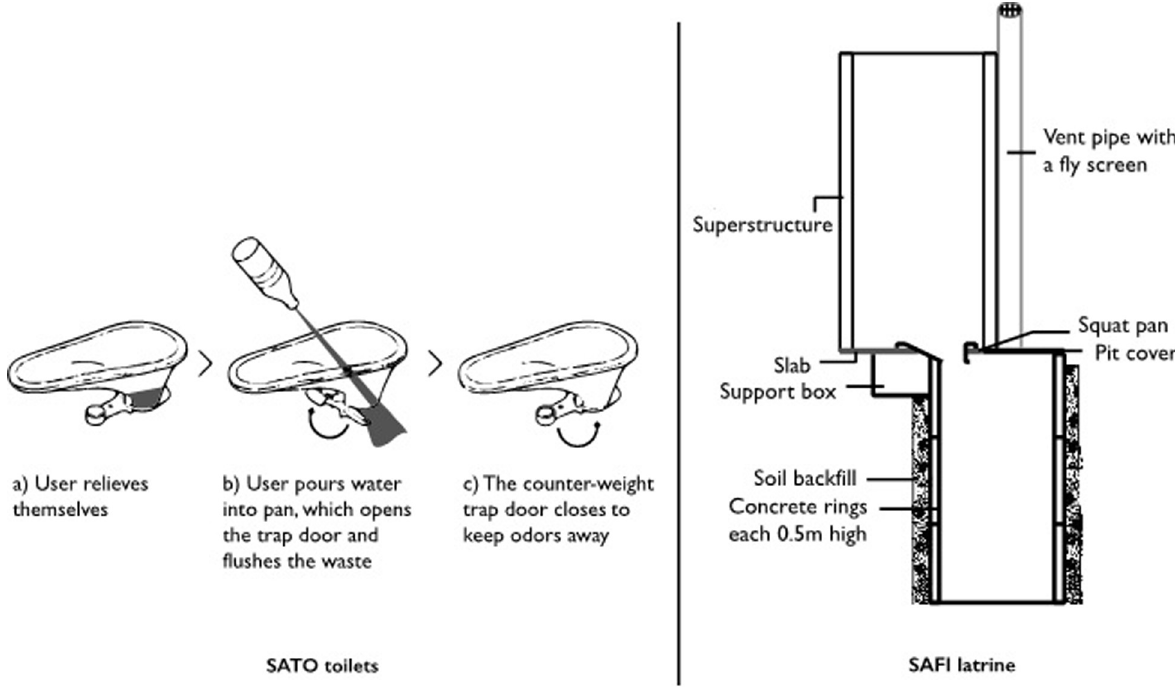
Fig 1. Cross sectional view of SATO toilets and SAFI